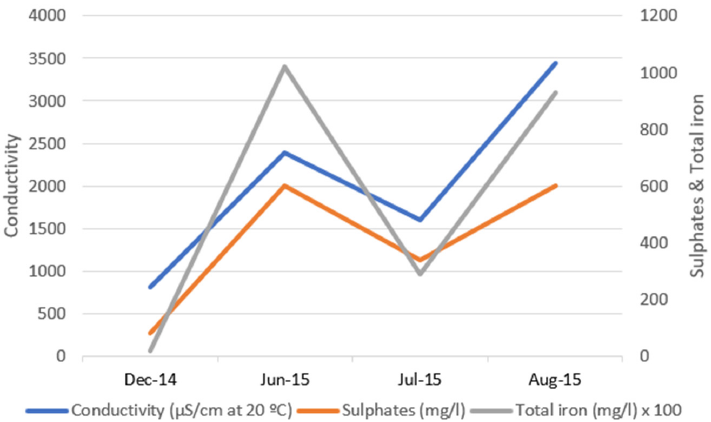
Figure 8. Conductivity, sulphates, and total iron of the analysis made at the Mosquitera mine. There is only one water point (used for industrial purposes) close to the study area